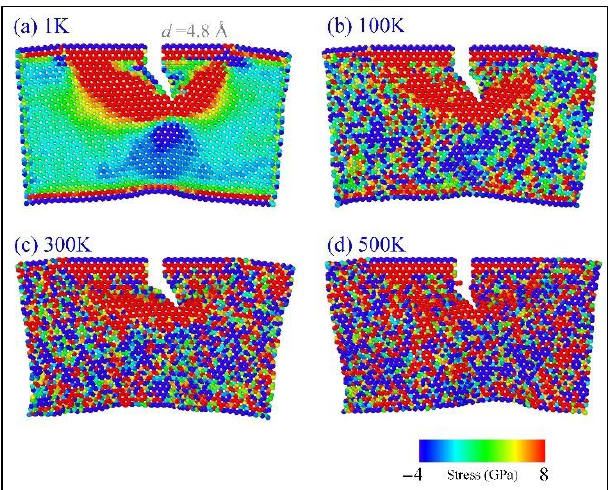
aligned with that at 1 K. For instance, the VPE curves at higher temperatures are not as smooth as that at 1 K; meanwhile, they may have obvious gaps.